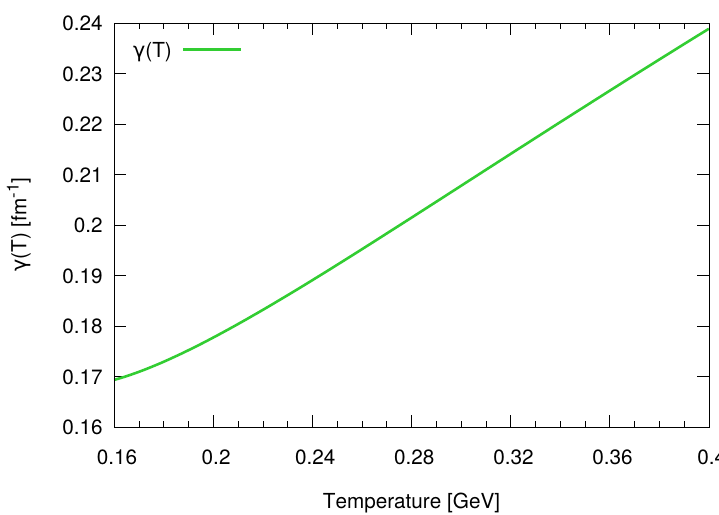
Figure 2. The friction coefficient for different temperatures.